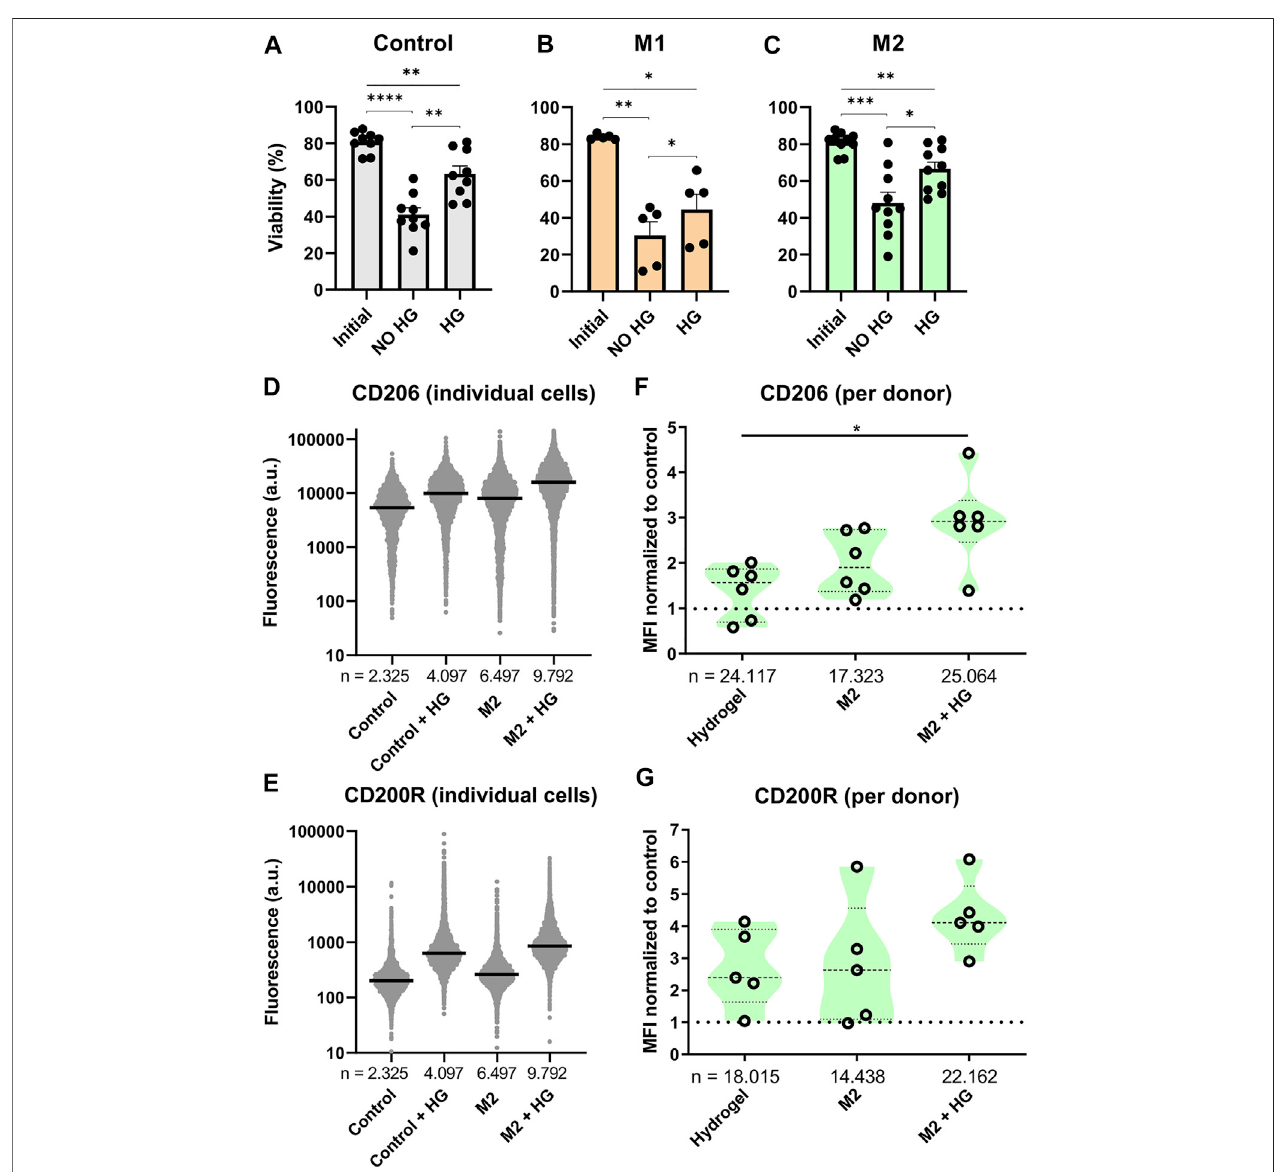
FIGURE 5 | Effects of thermo-reversible hydrogel droplets on single-cell macrophage culture. (A – C) Viability of macrophages before (Initial) and after 2 days of single-cell polarization in droplets either with (HG) or without (NO HG) PIC hydrogel incorporated. Bars represent control (9 donors), M1 (5 donors) and M2 (10 donors) with* p < 0.05,** p < 0.01,*** p < 0.001,**** p < 0.0001. (D,E) Fluorescencevaluesrepresentingsingle-cellexpressionofCD206andCD200R,formacrophagescultured in droplets for 2 days both with and without the addition of hydrogel and with and without M2 cytokines added. “ n ” indicates number of cells measured from 1 representativedonor. (F,G) ViolinplotsrepresentingCD206(sixdonors)andCD200R( fi vedonors)expressionofmacrophagesculturedindropletsfor2 dayswitheither M2stimuli,PIChydrogelorthetwocombined.Markerexpressionwasnormalizedtosingle-cellcontrolwithineachdonor. “ n ” indicatesnumberofcellsmeasuredfromall donors combined. Statistical signi fi cance was tested using repeated-measures one-way ANOVA with post-hoc Tukey ’ s test where * p < 0.05. If no signi fi cance is indicated, it was not found.